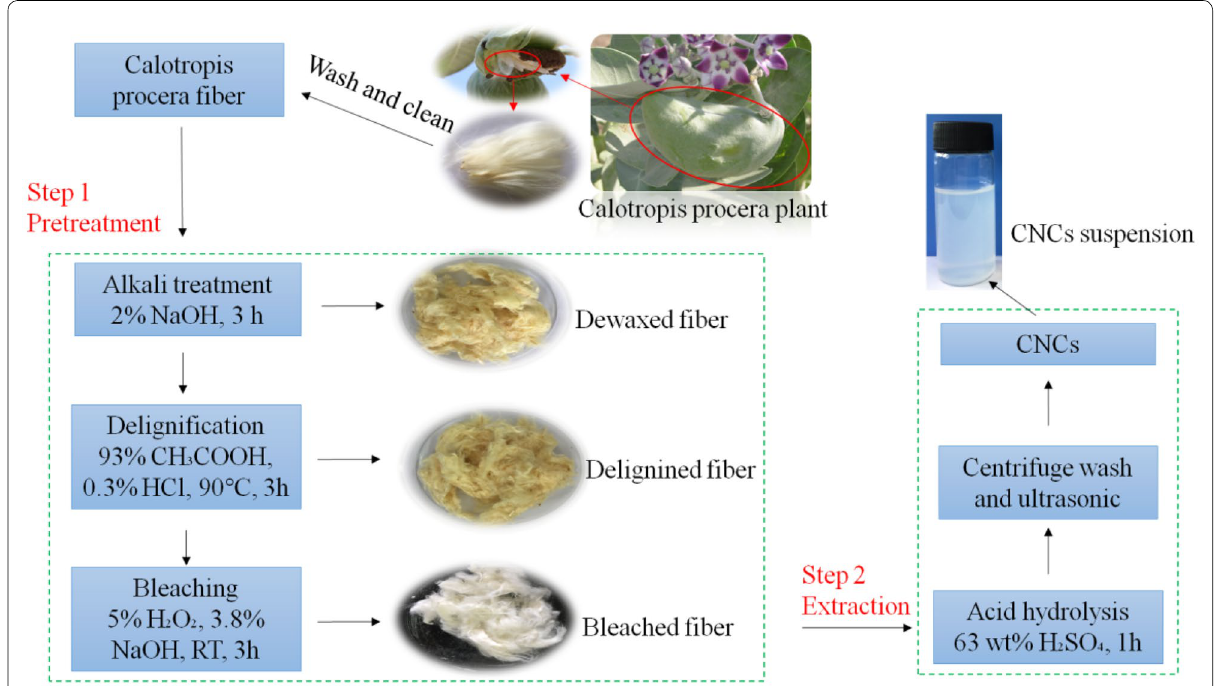
Fig. 1 Schematic illustration for the process of extraction CNC from Calotropis procera